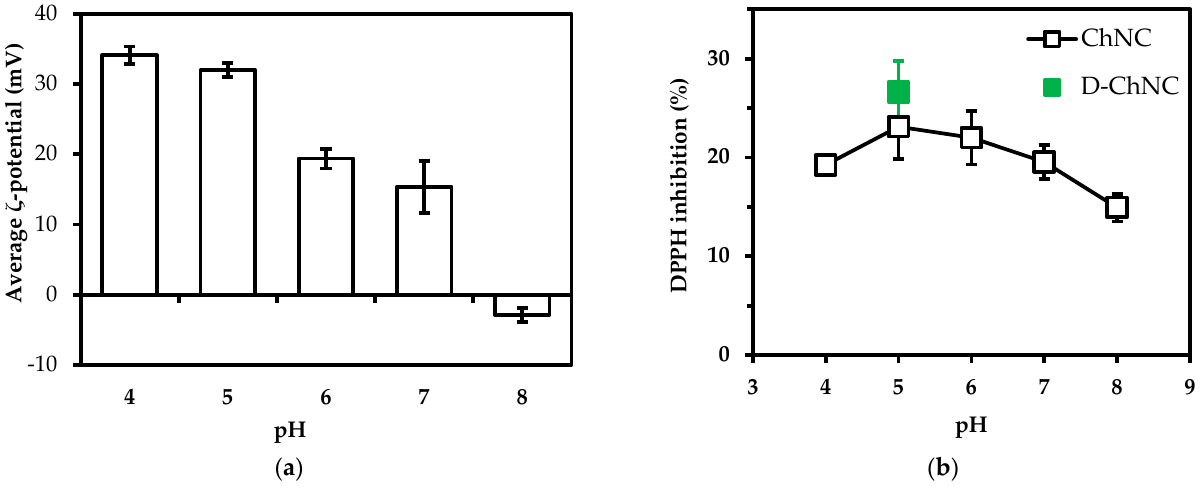
Figure 3. ( a ) The influence of pH on average ζ -potential of ChNC; ( b ) The DPPH inhibition (%) values at pH 4 − 8. 15 mg/mL concentration of ChNC was used during experiments.